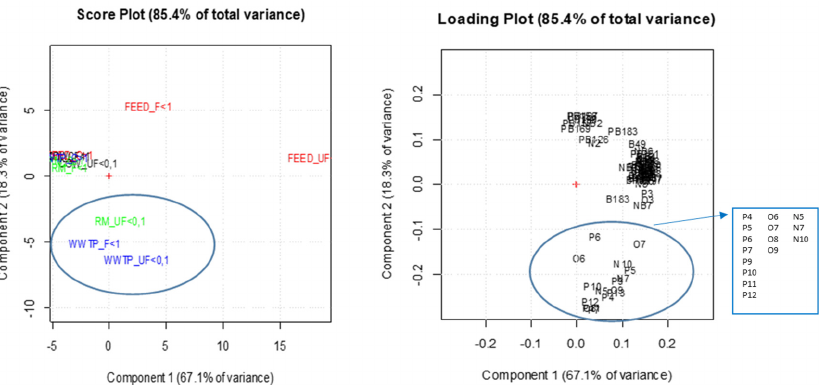
Materials (Table S1). sampling sites and in the three PM dimensional fractions. Compound codes, listed in the side square, are identified in the Supplementary